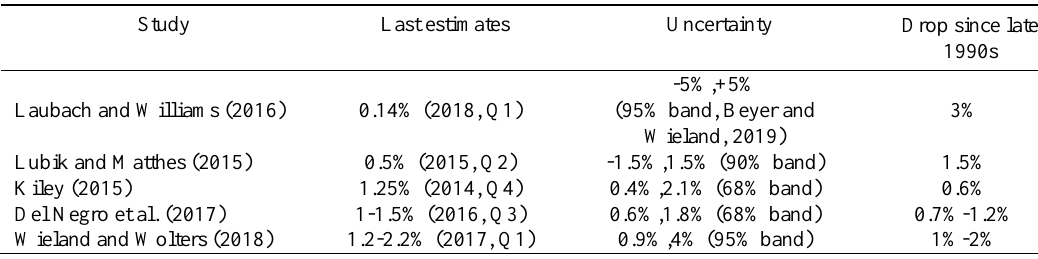
Table 1: Ranges of U.S. natural rate